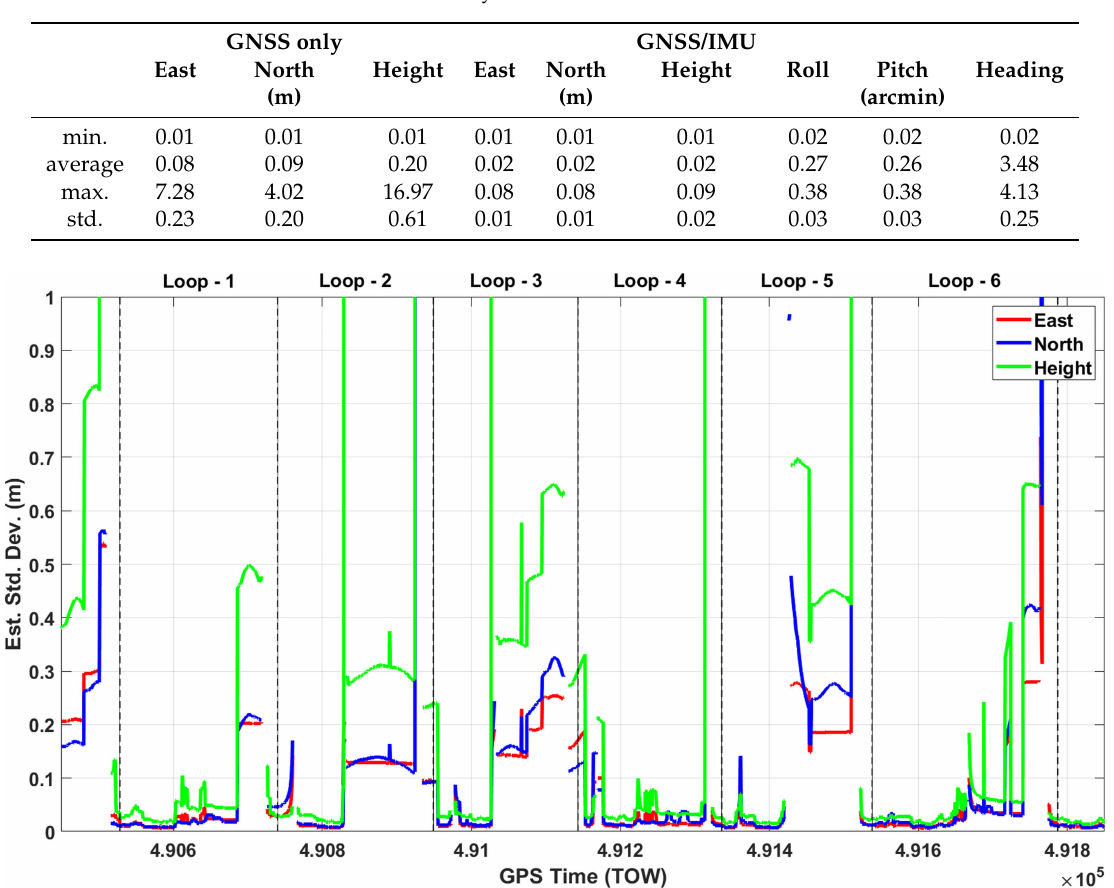
Table 2. Statistical analysis of estimated standard deviations.